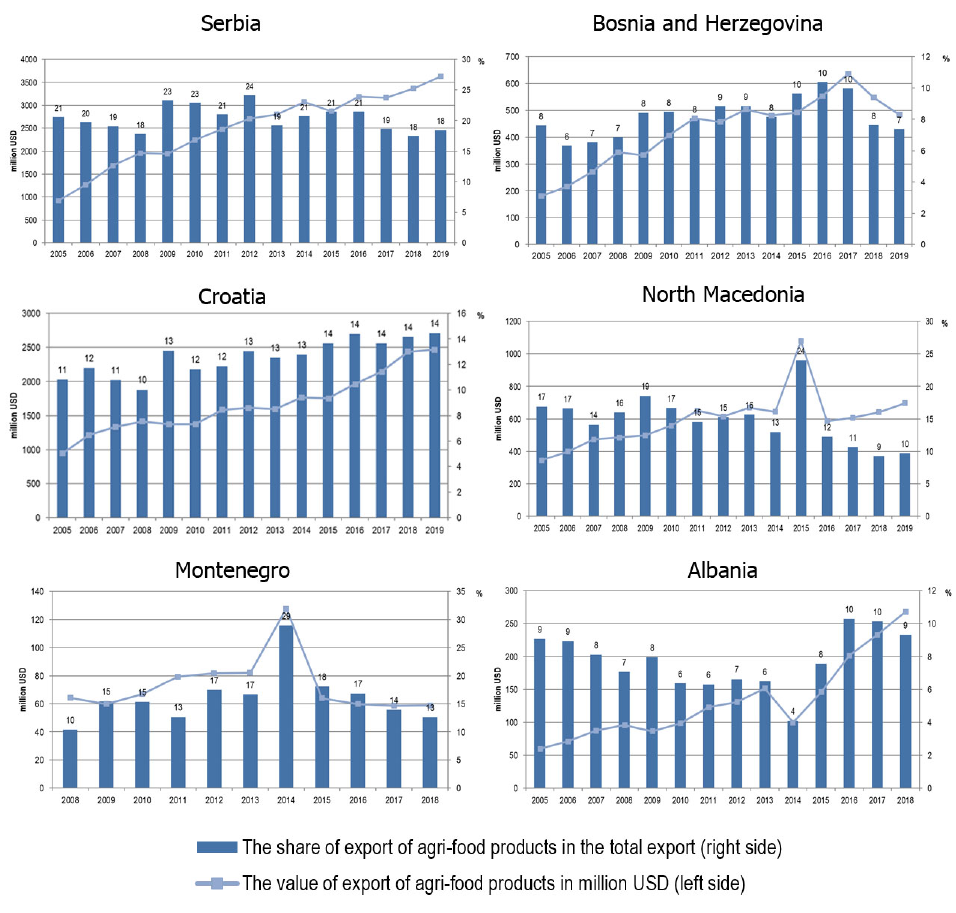
Figure 1. Export of agri-food products of the WB countries. Source: own research on basis of UN Comtrade [38].